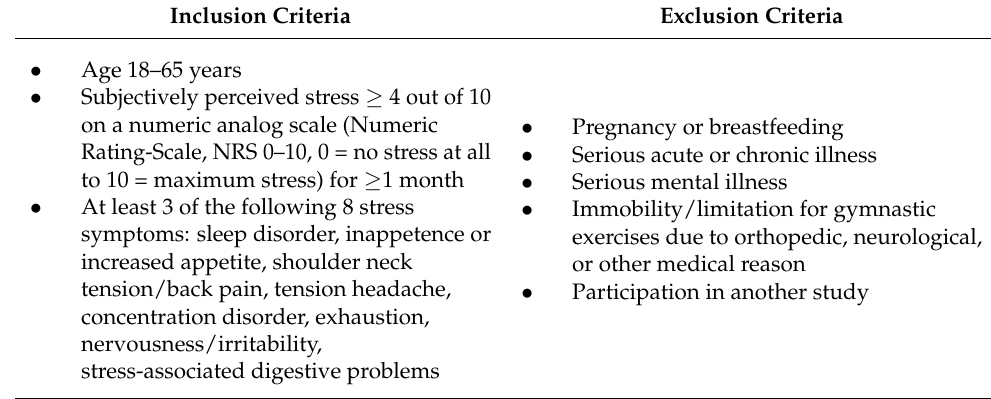
Table 1. Eligibility criteria.